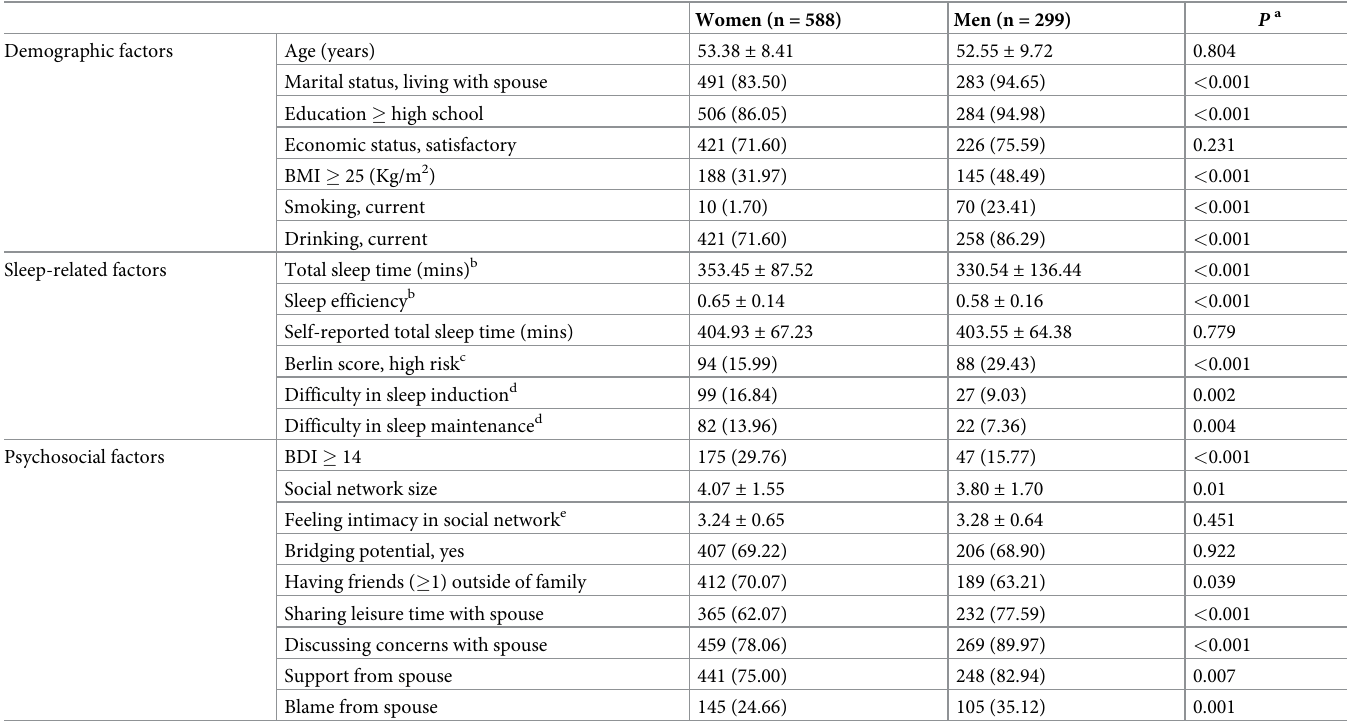
Table 1. Characteristics of participants of each sex.